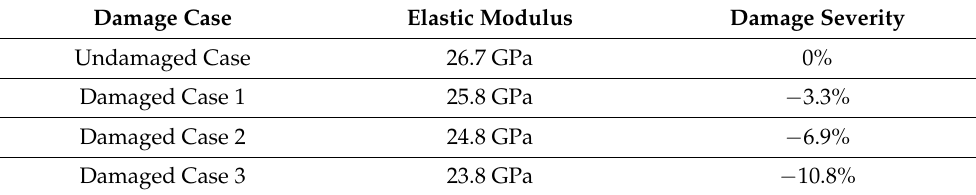
Figure 12. Locations of damage for RC-slab-bridge modeling. Table 4. Elastic modulus and damage severity of damage cases for RC-slab-bridge modeling .